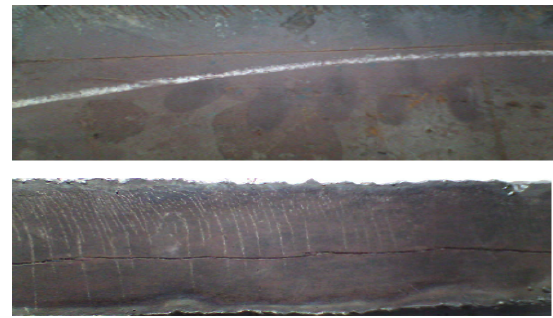
Figure 1: Cracks on web of